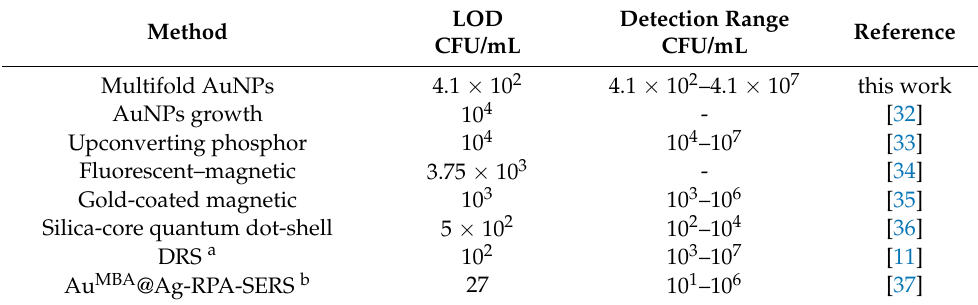
Figure 6. Sensitivity of the enhanced lateral flow assay against S. Typhimurium at 4.1 × 10 1 –4.1 × 10 7 CFU/mL in milk. Inset: photographs of the lateral flow assay results of S. Typhimurium at 4.1 × 10 1 – 4.1 × 10 7 CFU/mL in milk; data represent mean ± SD ( n = 3, * p < 0.05, ** p < 0.01 vs PBS group). Error bars indicate the standard errors of three independent experiments. Table 3. Comparison with the different enhanced LFA detecting Salmonella bacteria in milk.